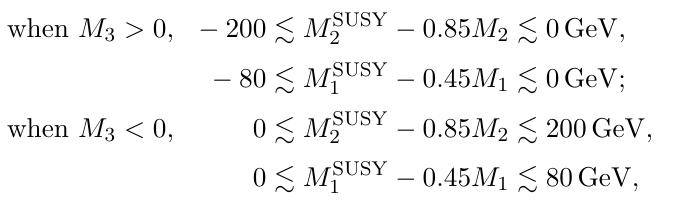
(left), SUSY contributions to muon g-2 1 (right), respectively. In these 2-dimension planes, 1